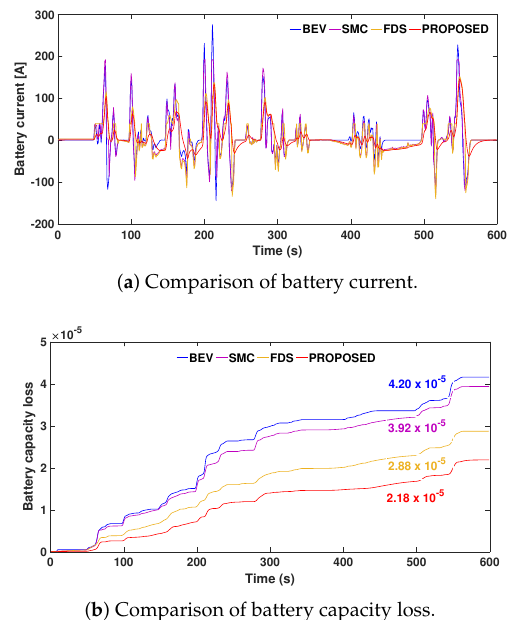
Figure 15. Comparison of BEV, SMC, FDS, and IHSEMS in terms of battery current ( a ) and battery capacity loss ( b ) under NYCC driving